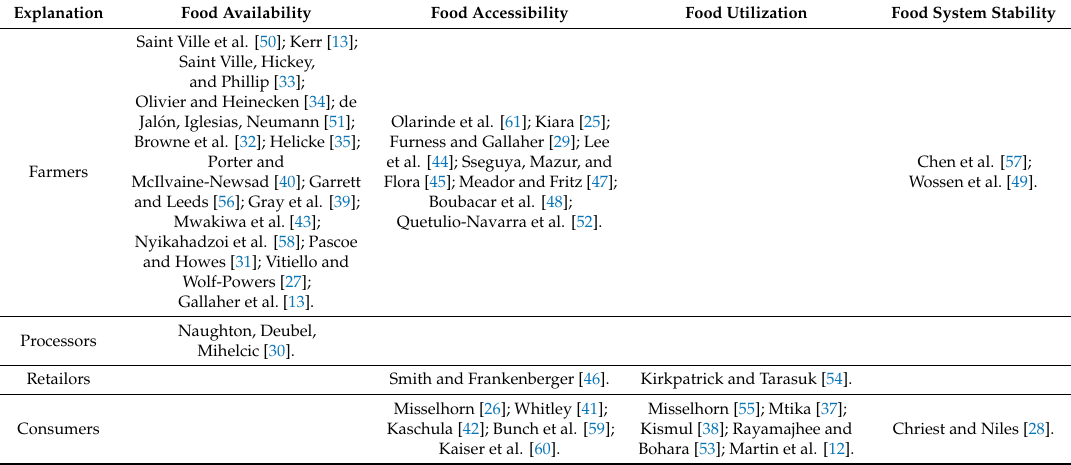
Table 3. Categorizing the articles based on their focus on food security strategies and on the food supply